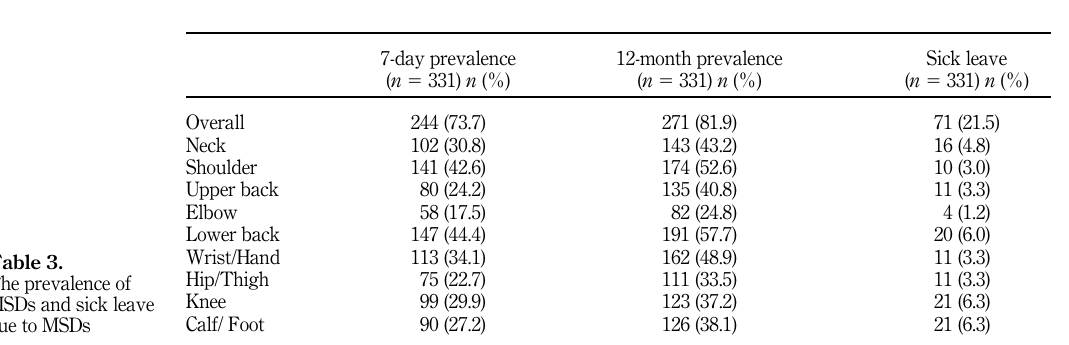
Figure 1. The floor mopping workflow